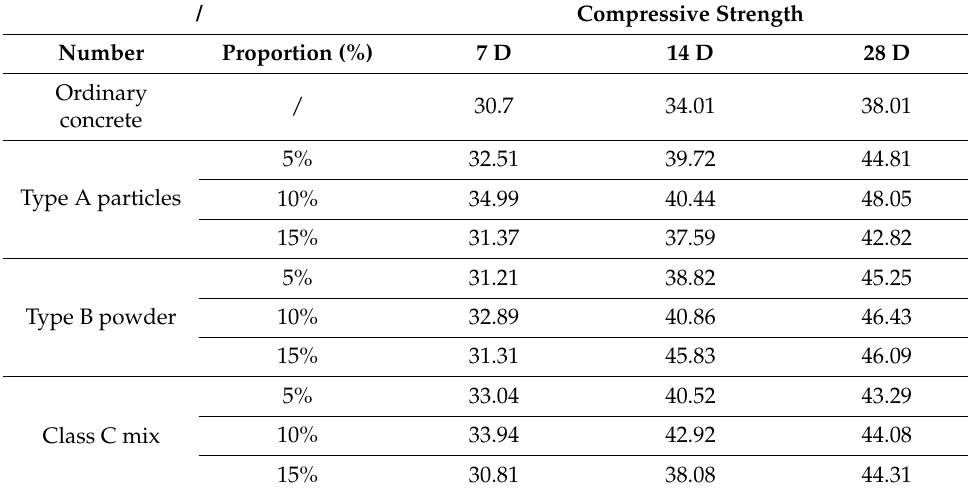
Table 2. Compressive strength range analysis table.